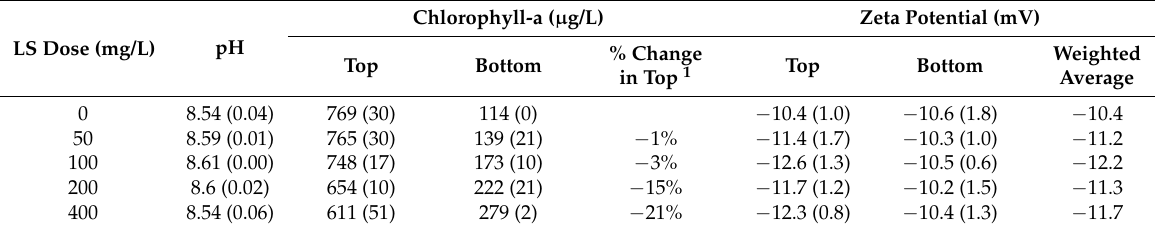
Table 3. pH, chlorophyll-a (micrograms per liter), and zeta potential (mV) in the samples collected from the top and bottom of the experimental units following treatment with LS ballast (in mg/L) only. The mean ( n = 3) and standard deviation (SD) of the initial chlorophyll-a concentration and pH of the lake water were 243 (5.4) µ g/L and 8.54 (0.04), respectively. The mean ( n = 3) and SD (in parentheses) of the parameters measured from experimentation are reported below. The weighted average zeta potential was computed using chlorophyll-a for